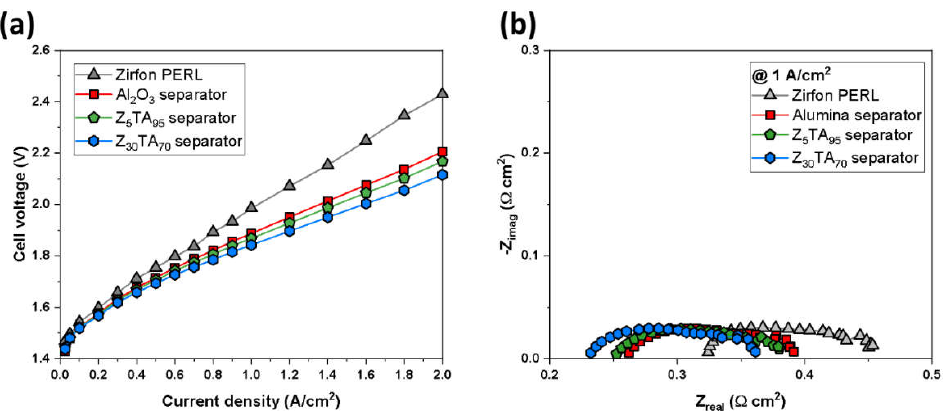
Figure 8. (a) Polarization curves for an electrochemical cell using Raney nickel as the cathodic and Ni-Fe LDH as the anodic electrode, respectively, in 30 wt.% aqueous solutions of KOH at 80 ◦ C temperature. ( b ) Nyquist plot of impedance spectra at 1 A/cm 2